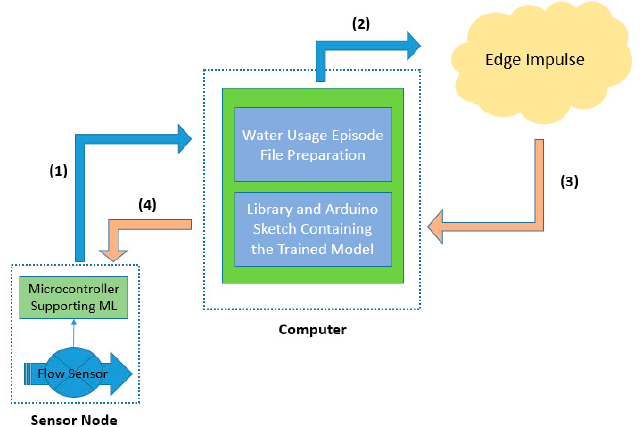
Figure 2. The analytic steps being necessary for the training of the proposed water usage event characterization solution.